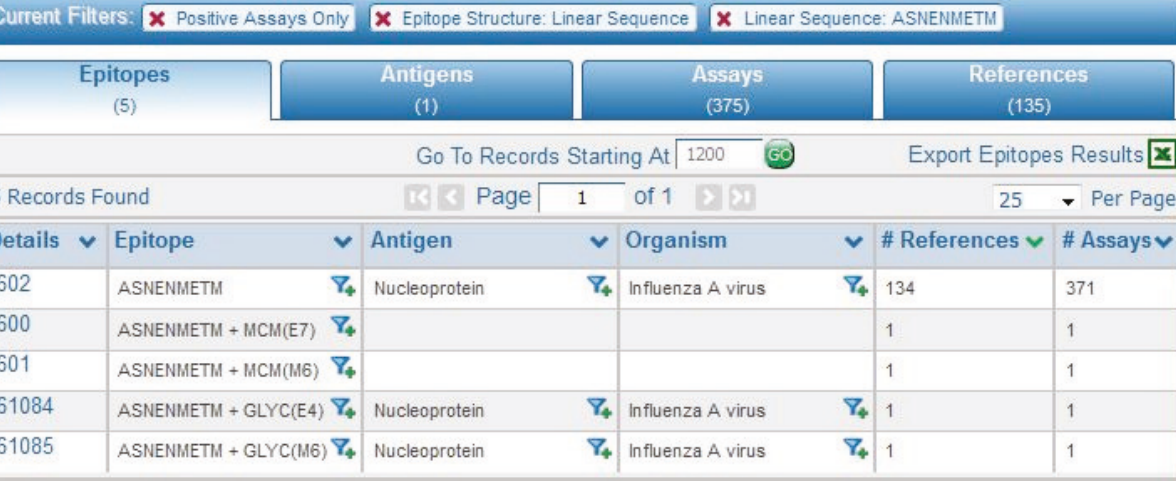
Figure 6: The results for a home page query for the linear sequence ASNENMETM, a well-characterized epitope of in fl uenza A virus nucleoprotein. The results include four epitopes with posttranslational modi fi